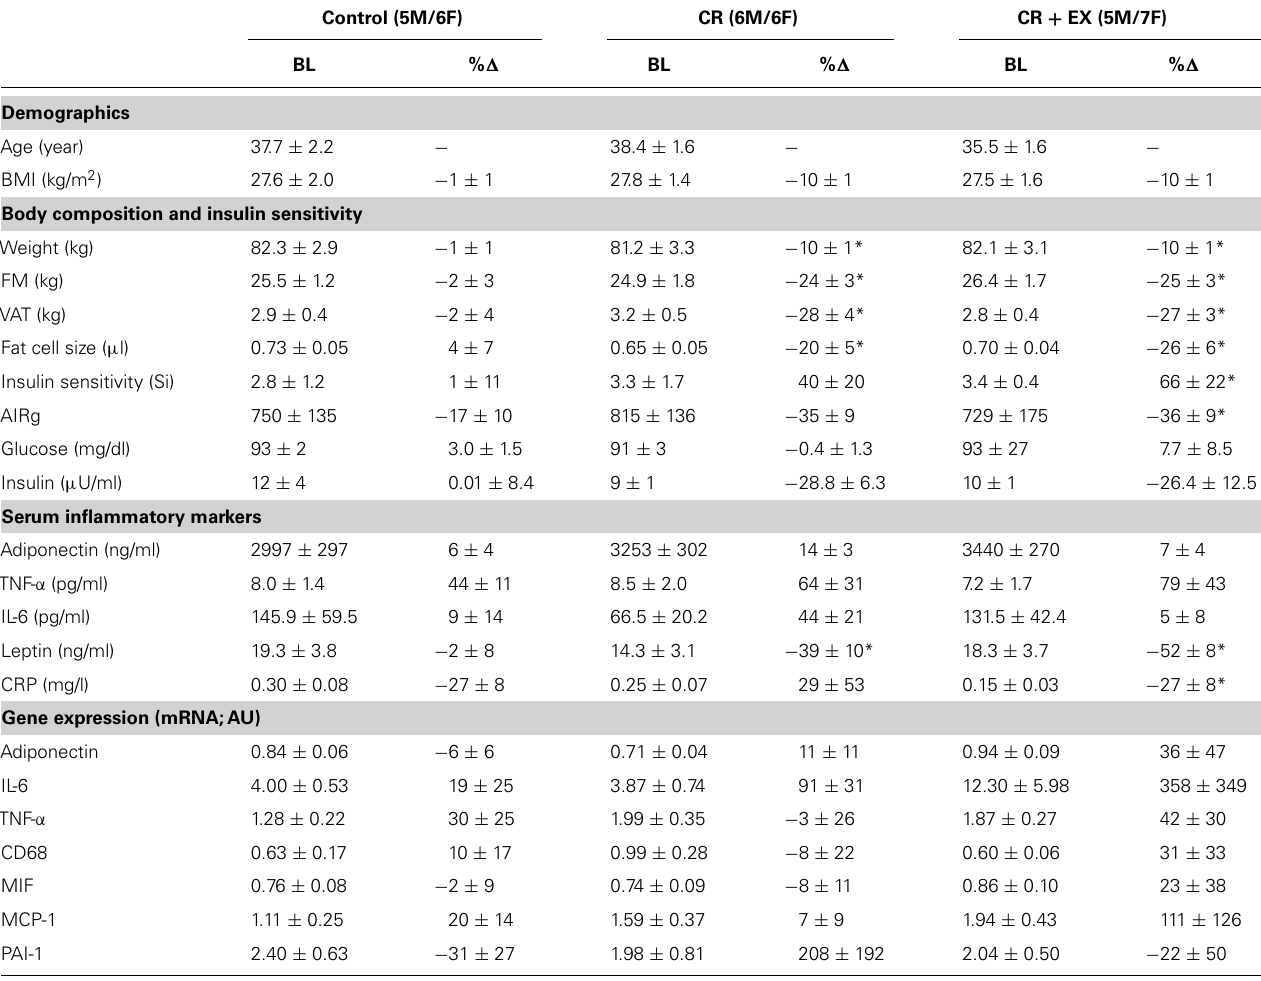
Table 1 | Effect of caloric restriction alone and with exercise on body composition, insulin sensitivity, and systemic markers of